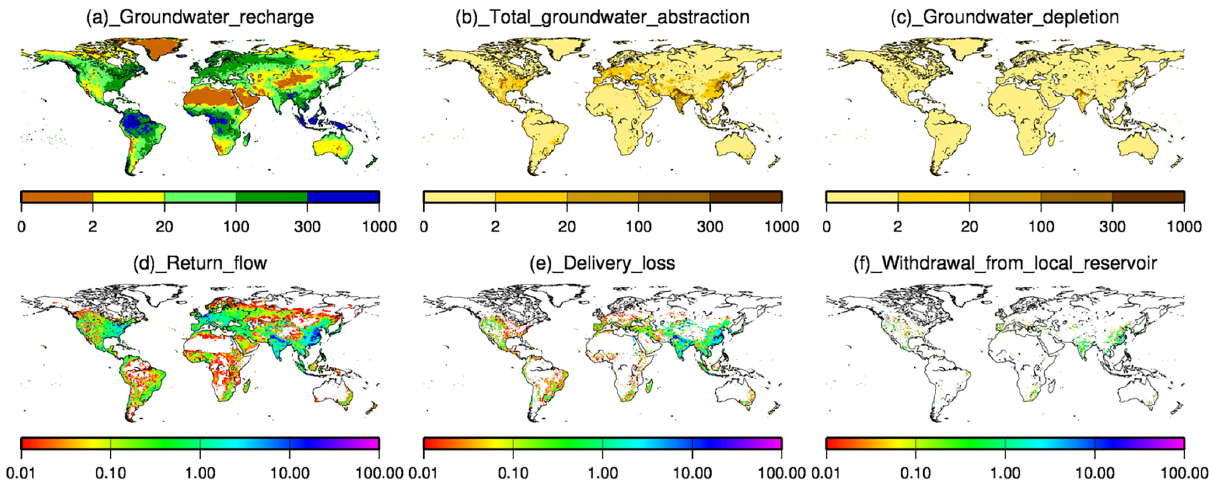
Figure 5. Global distribution of the mean (a) annual groundwater recharge (kgm − 2 yr − 1 ), (b) total groundwater withdrawal (m 3 s − 1 ), (c) nonrenewable groundwater withdrawal (m 3 s − 1 ), (d) return flow (m 3 s − 1 ), (e) delivery loss (m 3 s − 1 ), and (f) abstraction from local reservoirs (m 3 s − 1